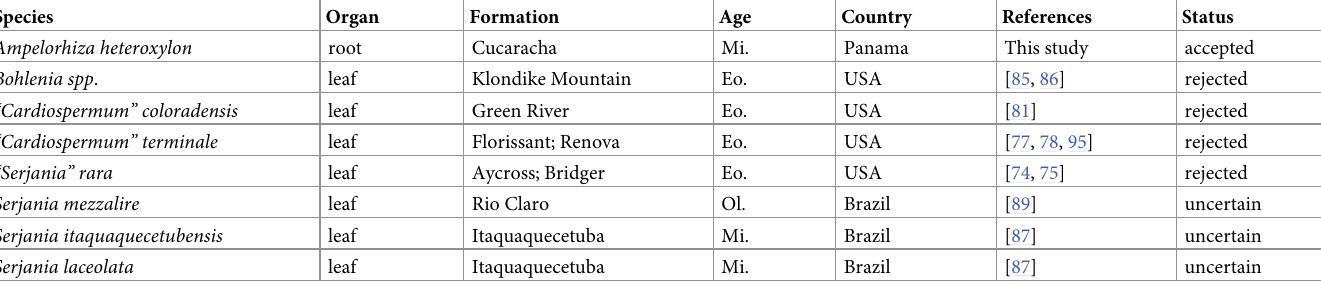
Table 1. Summary of pre-Quaternary macrofossils that have been assigned to Paullinieae.